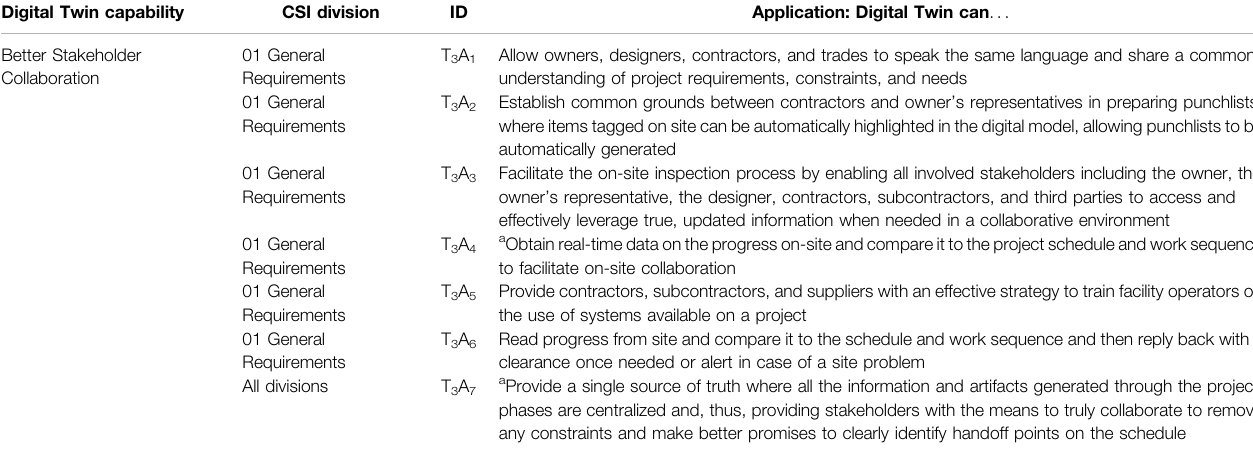
TABLE 5 | Digital Twin capability of Better Stakeholder Collaboration and the identi fi ed applications. Digital Twin capability